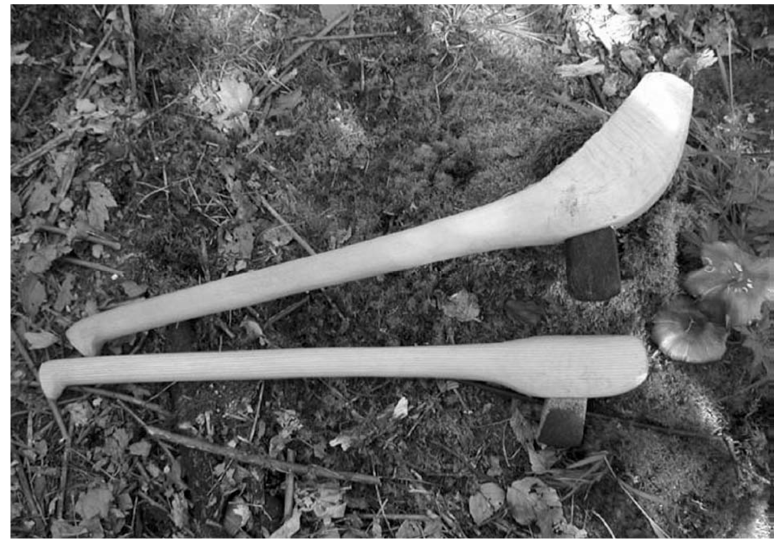
Figure 2. Functional replicas of Younger Neolithic stone axes shafted in straight and tangled shafts, produced by M. Kaiser, Freiburg.